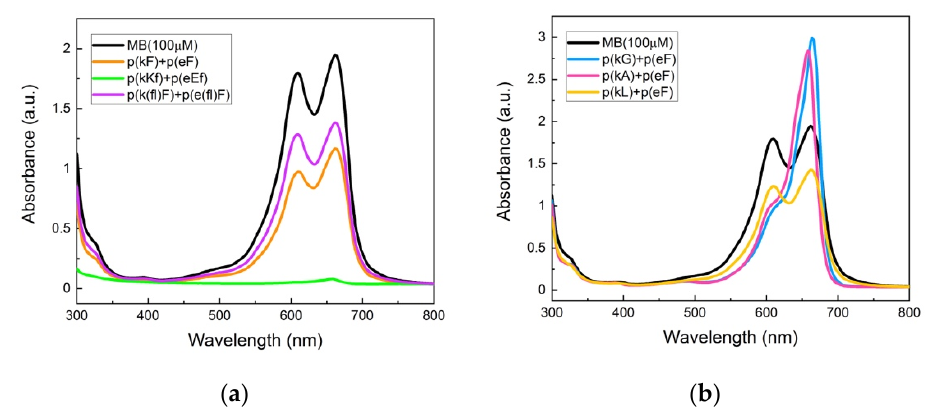
Figure 9. UV-vis absorbance spectroscopy of methylene blue and supernatant solutions: ( a ) p(kF) + p(eF), p(kKf) + p(eEf), and p(k(fl)F) + p(e(fl)F). The p(kKf) + p(eEf) supernatant solution has almost a flat absorbance, indicating complete encapsulation of MB molecules within the complex phase. p(k(fl)F) + p(e(fl)F) has a higher absorbance intensity than p(kF) + p(eF) likely due to reduced π - interactions with MB as the result of the fluorine substitution on the phenylalanine ring; ( b ) p(kG), p(kA), and p(kL) sequences paired with p(eF). The supernatant solution of p(kL) + p(eF) has a lower absorbance intensity compared to p(kG) + p(eF) and p(kA) + p(eF), indicating more encapsulation of MB within the complex phase. p(kL) is more hydrophobic than p(kG) and p(kA) providing stronger interactions with MB. All solutions were prepared with 100 µM of MB and 5 mM of polymers on a monomer charge basis.